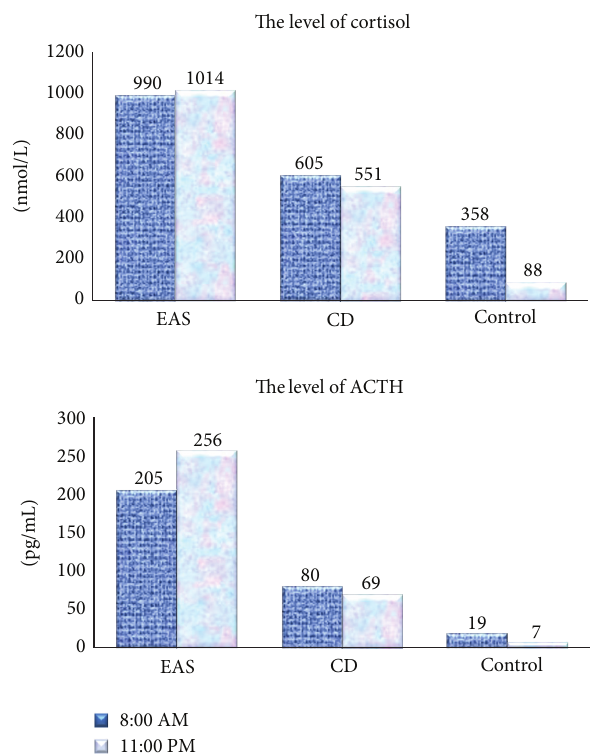
Figure 1: Cortisol (pmol/L) and ACTH (pg/mL) levels during a 24- hour period in patients with Cushing’s disease and ectopic ACTH secretion compared with controls.